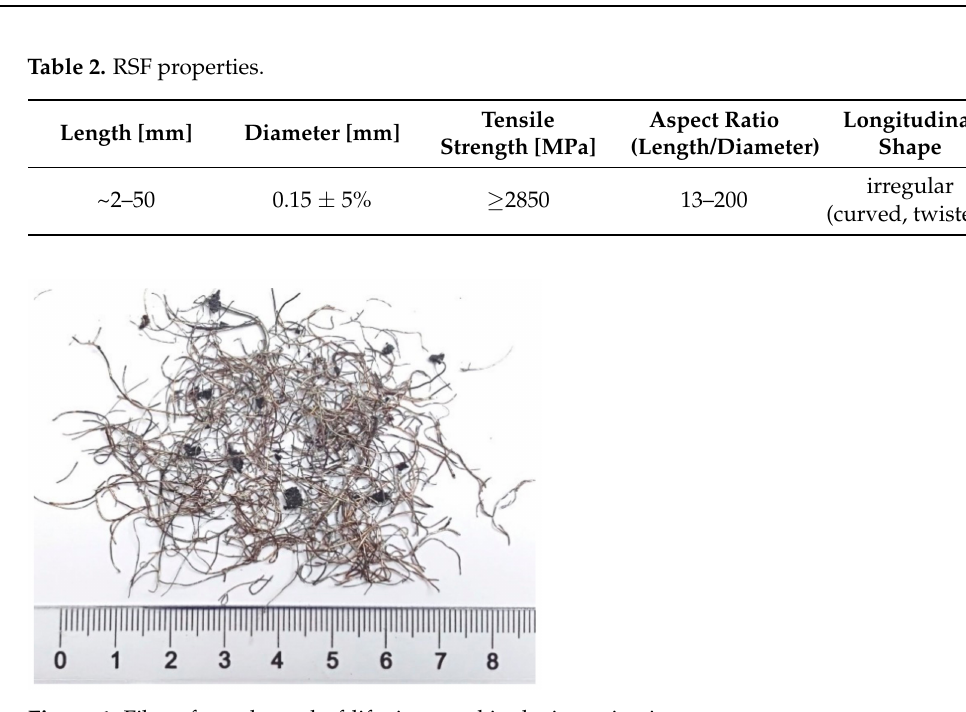
Figure 1. Fibres from the end-of-life tires used in the investigation. The slump flow tests of fresh mixes were performed according to PN-EN 12350-5 [21]. The addition of the RSF reduced the slump flow diameter (Table 3). Table 3. Slump